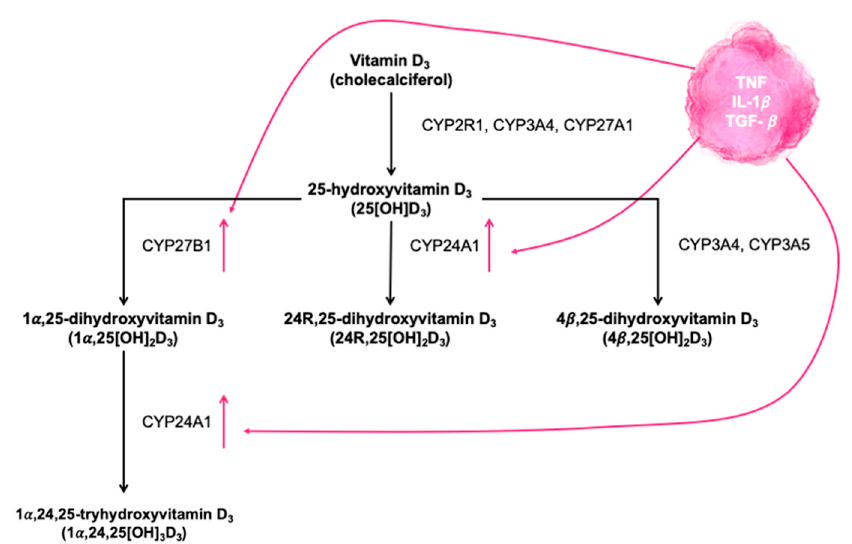
Figure 2. The main oxidation pathways of vitamin D3 and the enzymes catalyzing each step. The cytokine profile that dominates inflammatory respiratory diseases (asthma and COPD) exerts different actions on oxidation enzymes, enhancing the passage to inactive compounds without biological effects.